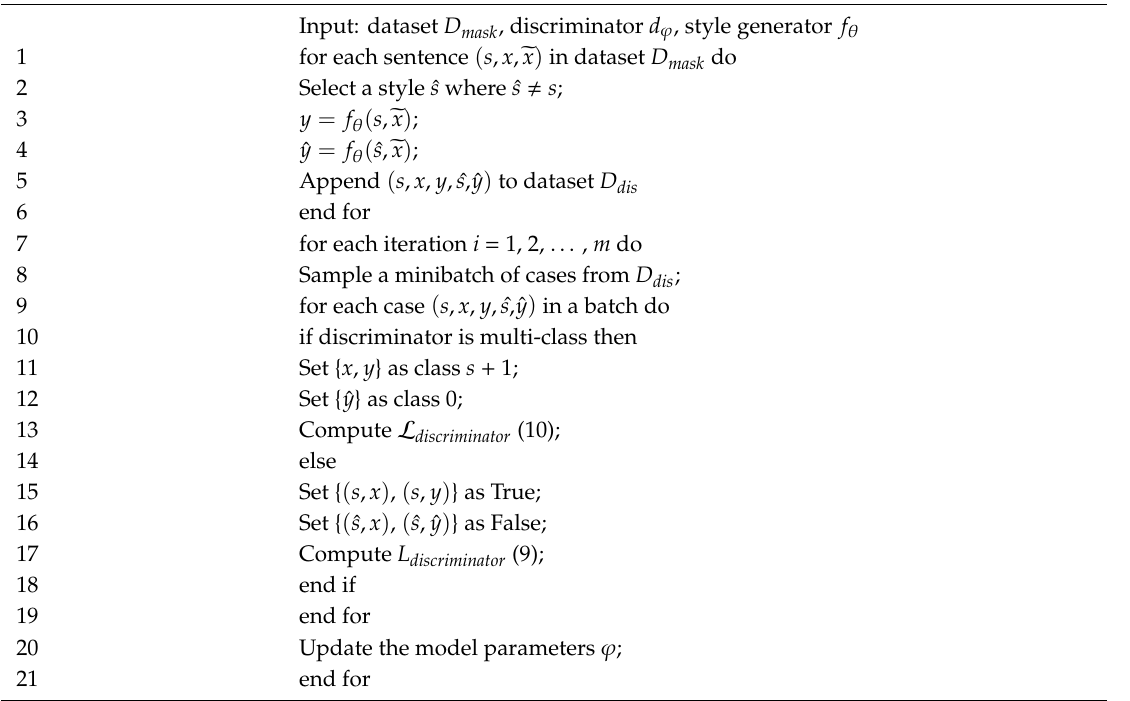
Algorithm 1: The Training of the